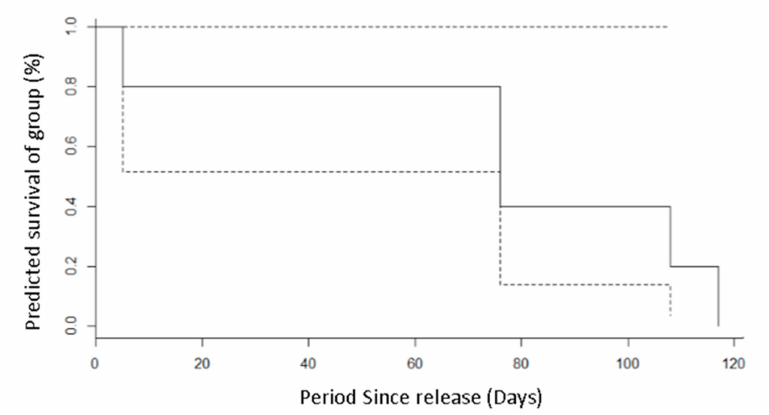
Figure 4. Kaplan–Meier survivorship curve showing the survival and last known points of capture Figure 2017. 95% confidence represented by the dashed line, with survival represented by the solid